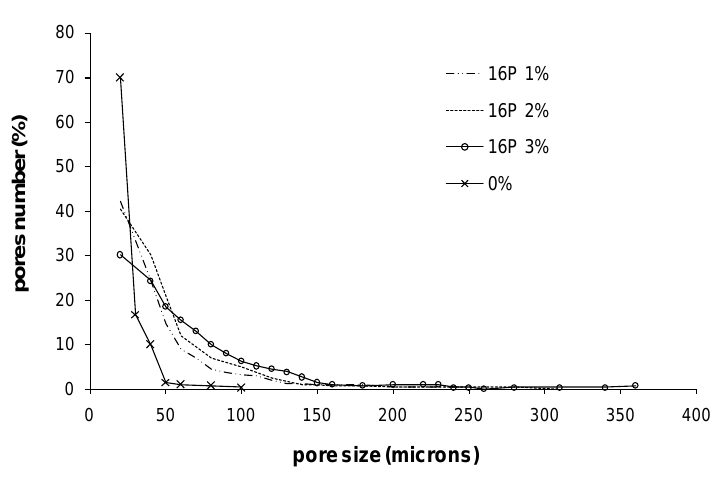
Figure 4. Statistical analysis of pore size by image analysis of SEM results: ( a ) SE16P; ( b ) SE11S.